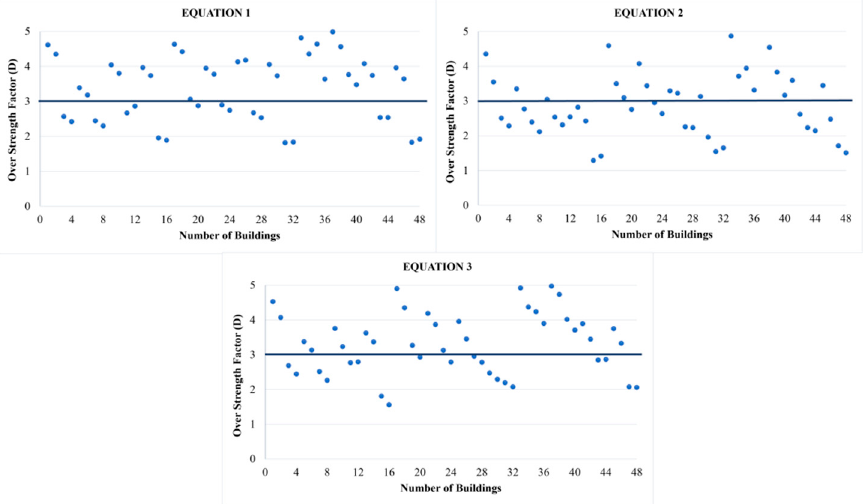
Figure 17. Distribution of the over-strength factor of the models of buildings designed different equations.